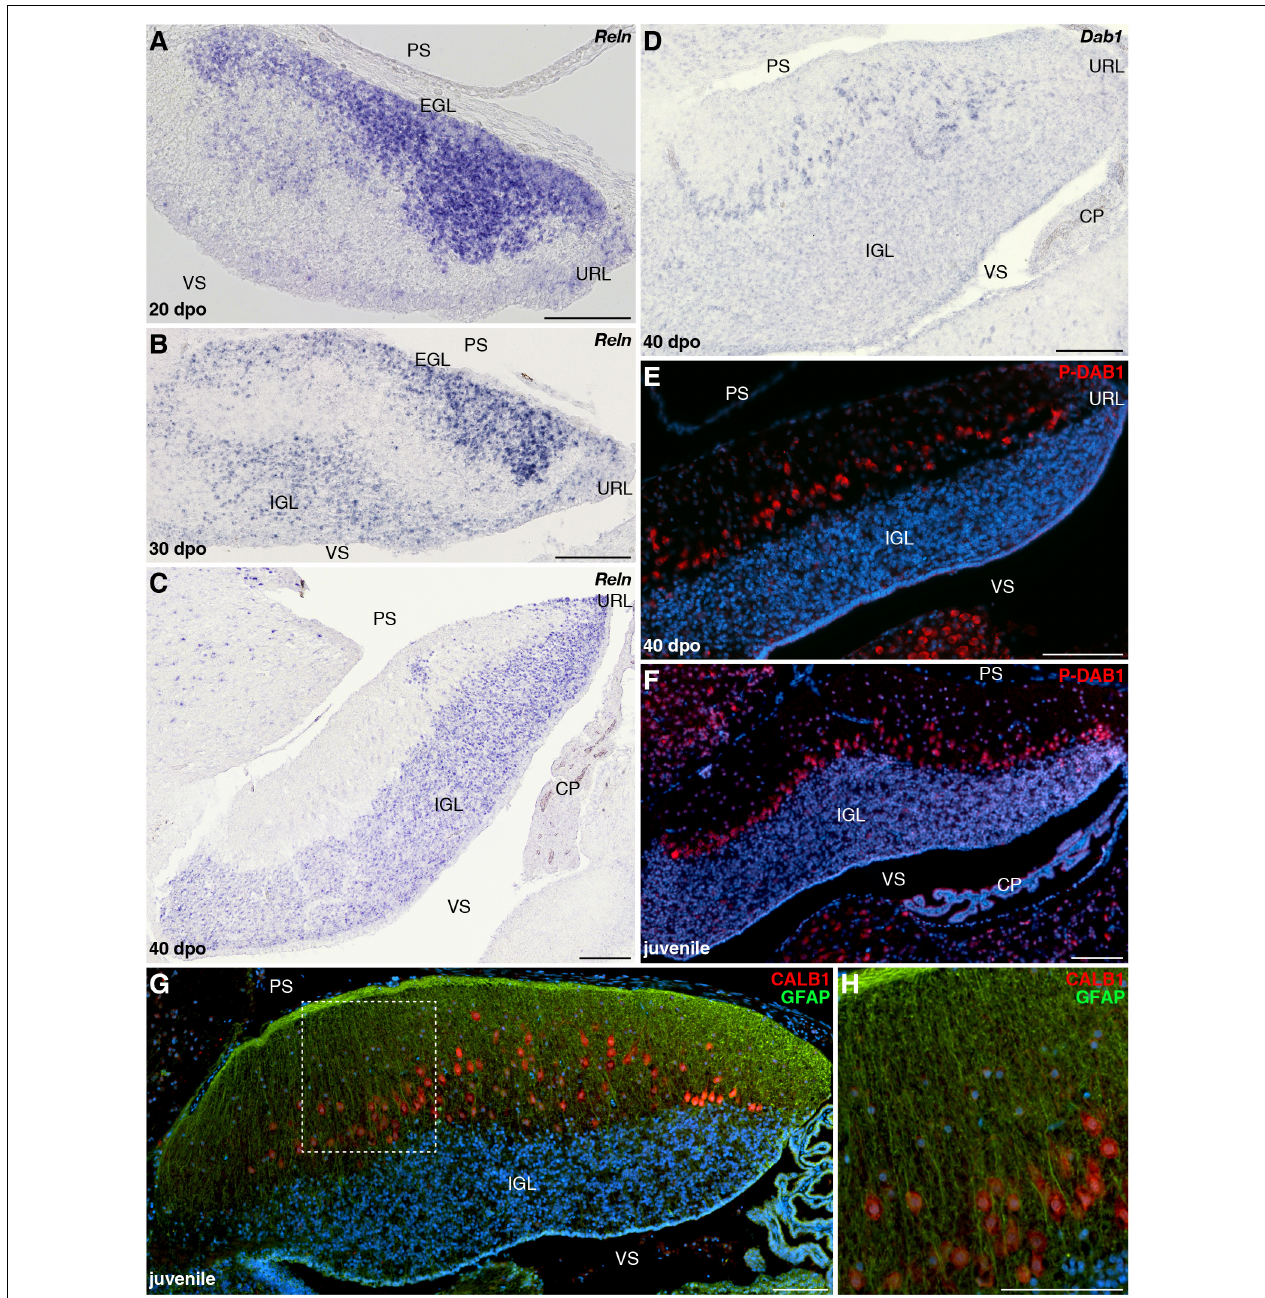
FIGURE 8 | Developmental characterization of RELN signaling pathway and mature glial fiber organization in the cerebellum of B. fuliginosus . (A–D) ISH for Reln (A–C) or Dab1 (D) at various indicated embryonic stages (20, 30, and/or 40 dpo) in the cerebellum of B. fuliginosus . (E,F) IHC for P-DAB1 (red staining) at 40 dpo (E) and juvenile (F) stages. (G,H) Double IHC for CALB1 (red) and GFAP (green) in the cerebellum of juvenile B. fuliginosus . A high magnification view of the area contained in the dashed rectangle in panel (G) is shown in panel (H) . PS, pial surface; EGL, external granule layer; IGL, internal granule layer; VS, ventricular surface; URL, upper rhombic lip; CP, choroid plexus. Scale bars: 100 µ